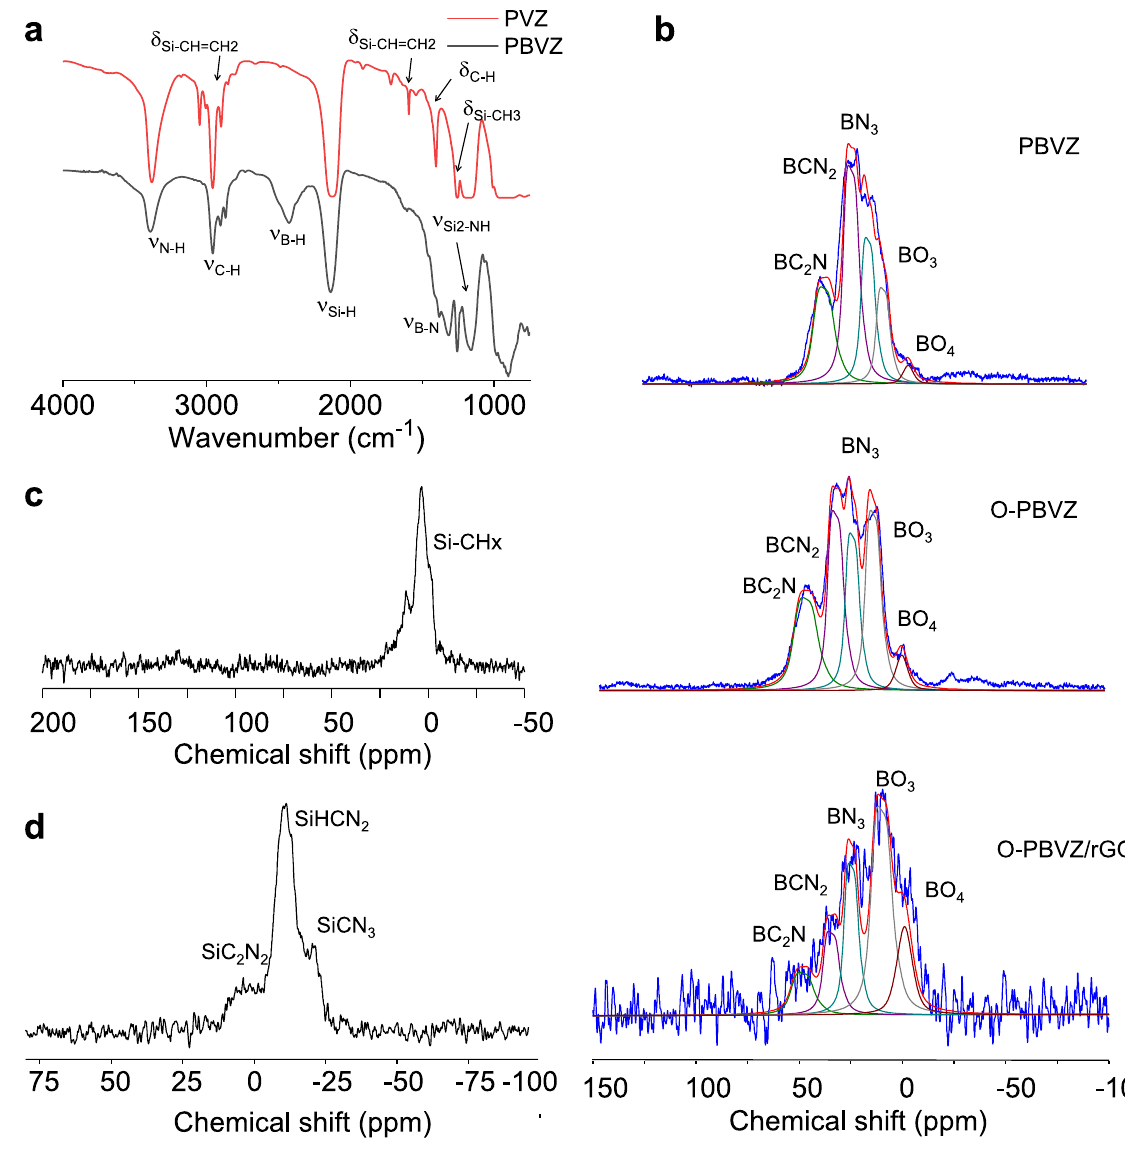
Figure 1. ( a ) FTIR spectra of PVZ and PBVZ preceramic polymers. ( b ) 11 B MAS NMR spectra of PBVZ, O-PBVZ polymers and O-PBVZ/rGO composite. ( c ) 13 C CP MAS NMR spectrum of PBVZ polymer and ( d ) 29 Si MAS NMR spectrum of PBVZ